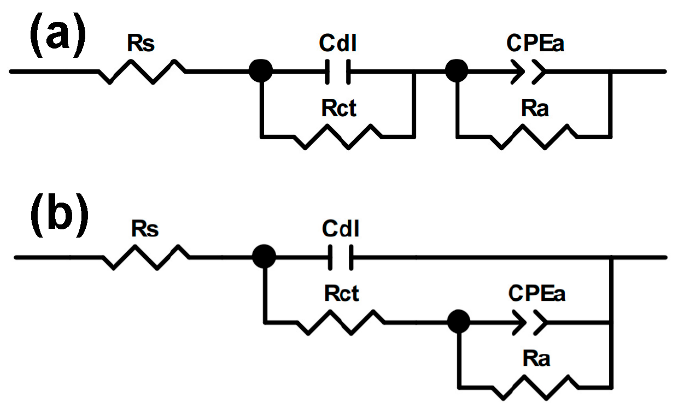
Figure 10. The equivalent electrical circuits that were used to fit the impedance spectra obtained in this study for ( a ) no/weak adsorption and ( b ) strong adsorption, where R s is the solution resistance, C dl is the double layer capacitance, R ct is the charge transfer resistance, and the constant phase element CPE a and R a are the adsorption-related capacitance and resistance, respectively. In these equivalent circuits, the constant phase element ( CPE ) was used to account for the inhomogeneity in the surface coverage by adsorbed hydrogen. The CPE values were recalculated into the capacitance by Equations (6) and (7), colloquially known as Brug et al.’s effective capacitance equation [55,56].